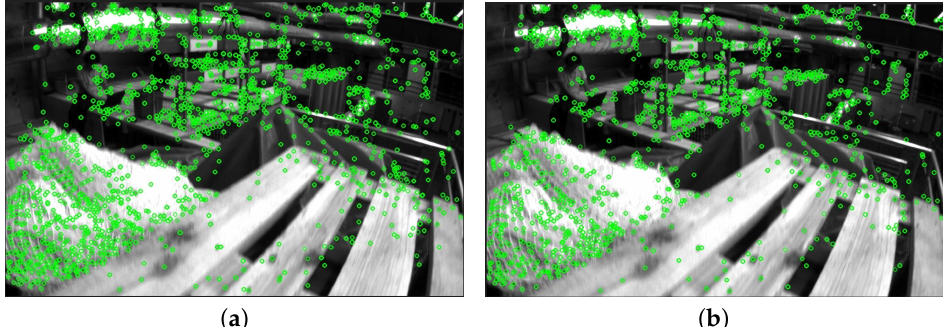
Figure 9. Extraction results of feature points of the 11th group of images to be registered. ( a ) Feature point extraction result of the SIFT algorithm; ( b ) feature point extraction result of this algorithm.